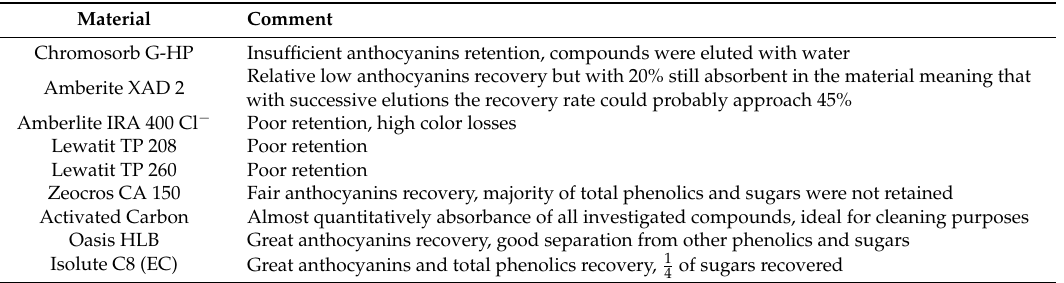
Table 5. General remarks regarding the materials tested during SPE